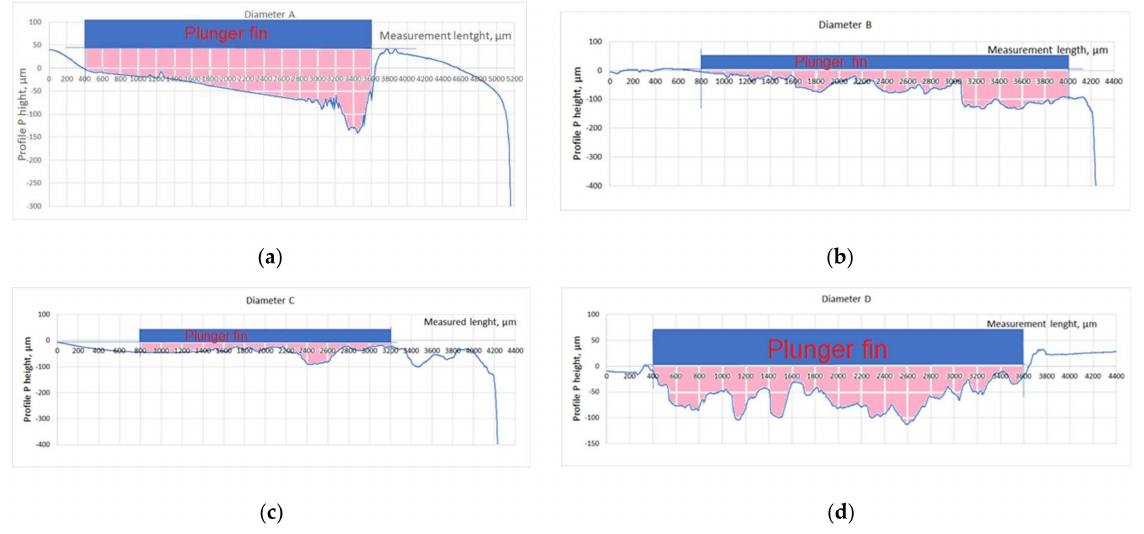
Figure 15. Sample profile of the worn initially DLC covered surfaces of steel shaft shoulders after the mating with the front planes of steel plunger fins. ( a ) Shaft shoulder surface A; ( b ) Shaft shoulder surface B; ( c ) Shaft shoulder surface C; ( d ) Shaft shoulder surface D. Blue rectangle—a schematic view of the fragment of the plunger fin positioned in the operational position during mating with the shaft shoulder cylindrical surface, pink area—the corresponding cross-section area of removed material of the shaft